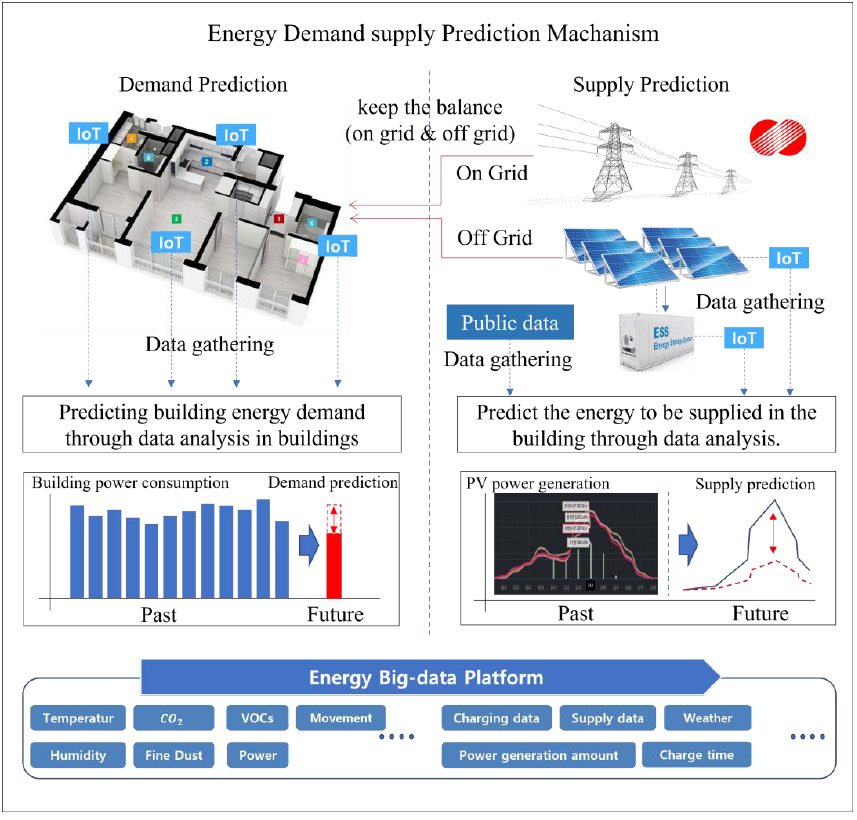
Figure 9. Building energy supply and demand mechanism.